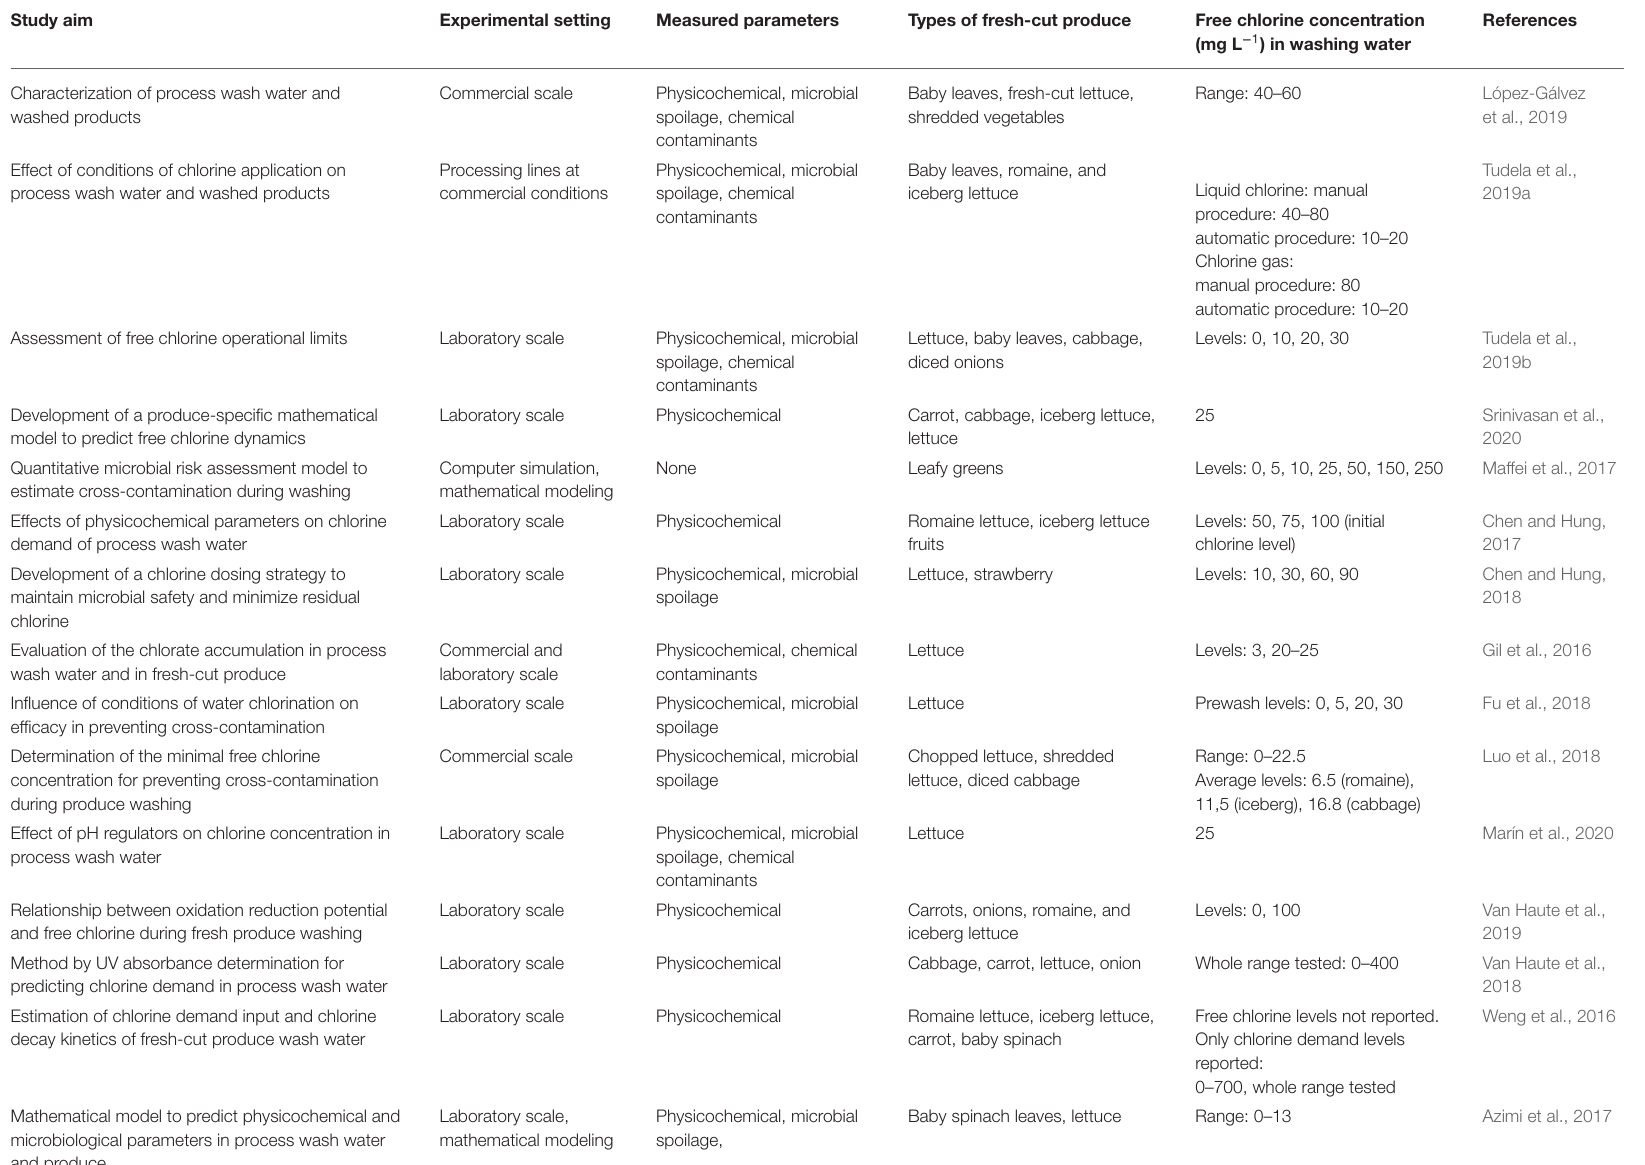
TABLE 1 | Summary of recent studies aimed at optimizing conditions of chlorine application during washing water